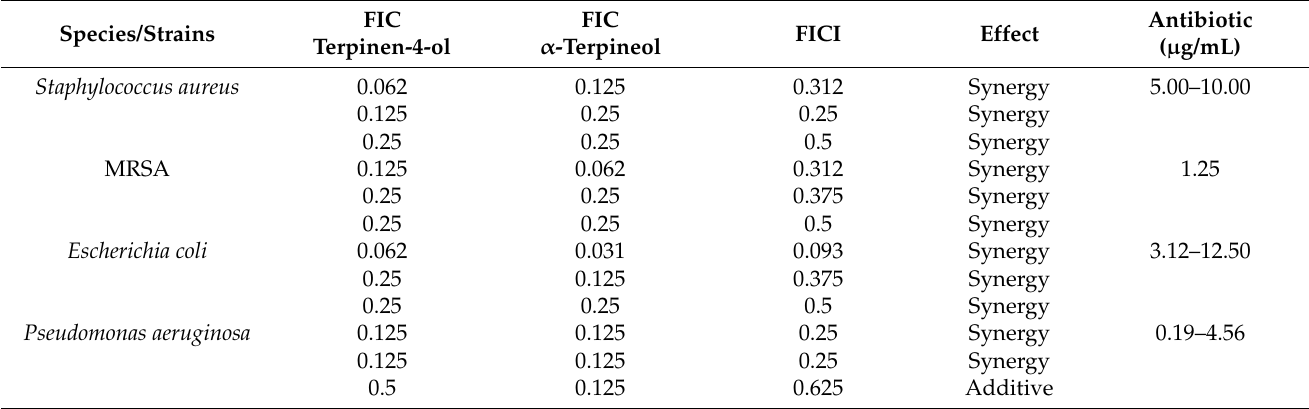
Table 2. Bactericidal synergy between α -terpineol and terpinen-4-ol. FIC values of α -terpineol and terpinen-4-ol were obtained from three independent assays on the four bacteria reported in Figure 1. The effect deduced from the calculated FICI are detailed. Antibiotics used as controls are ampicillin for Staphylococcus aureus and MRSA, amoxicillin for Escherichia coli , and gentamycin for Pseudomonas